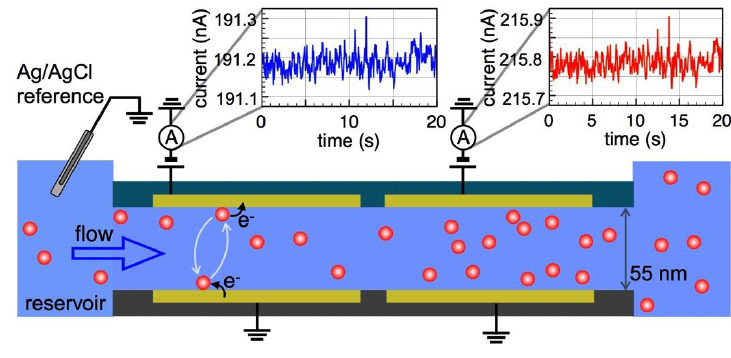
Figure 1. Schematic of the experimental setup. Fluctuations in the number density of electroactive molecules are used as tracers of liquid flow as solution is transported through a nanochannel. The fluctuations are detected electrically by redox cycling and their time of flight between the detectors—or, equivalently, the flow velocity—is then determined by cross correlation analysis of current-time traces (curves in the insets are a schematic